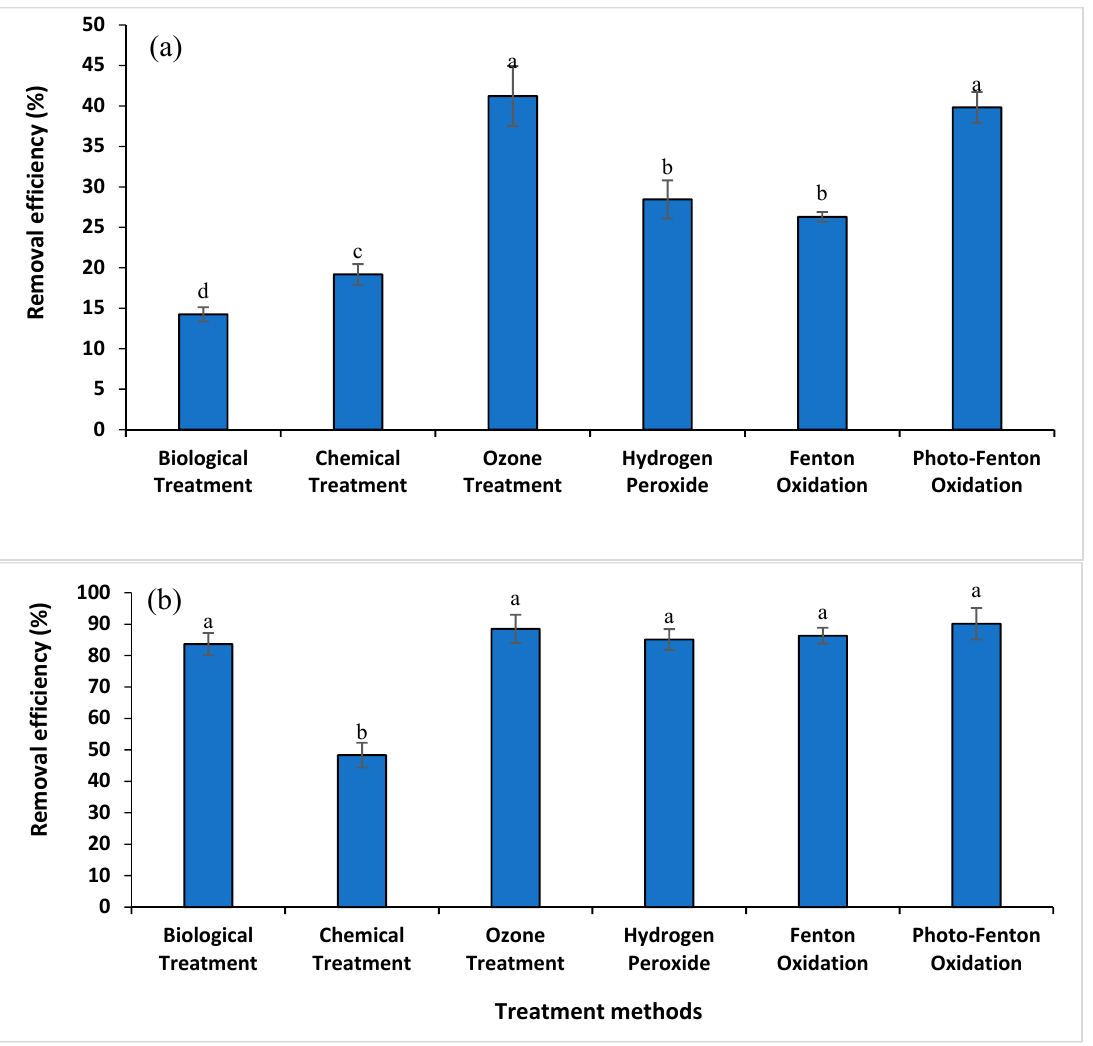
Figure 10. ( a ) Comparison of color removal efficiencies of different treatment methods applied to raw pulp and paper wastewater. ( b ) Comparison of COD removal efficiencies of different treatment methods when applied to raw pulp and paper wastewater. Mean values are presented with standard deviation. Different letters (a–d) show significant differences between treatments methods.